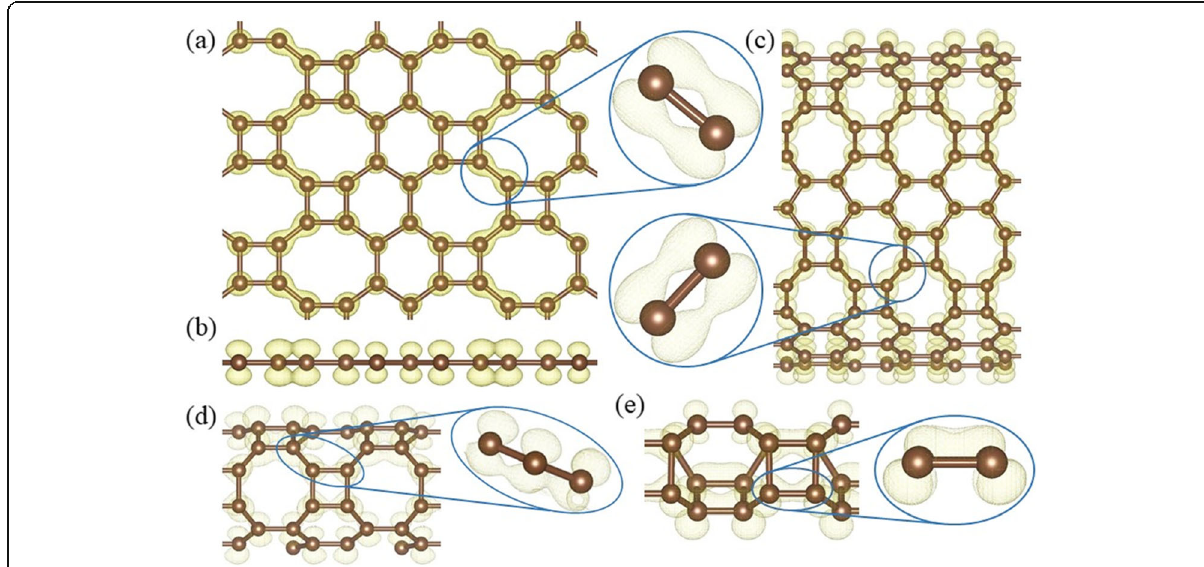
Fig. 10 Band decomposed charge densities around the Fermi level of ( a ) HOT graphene, ( b ) the corresponding side view, and HOT graphene nanotubes ( c ) (0,1)6, ( d ) (0,1)2, and ( e ) (0,1)1 with corresponding enlarged side